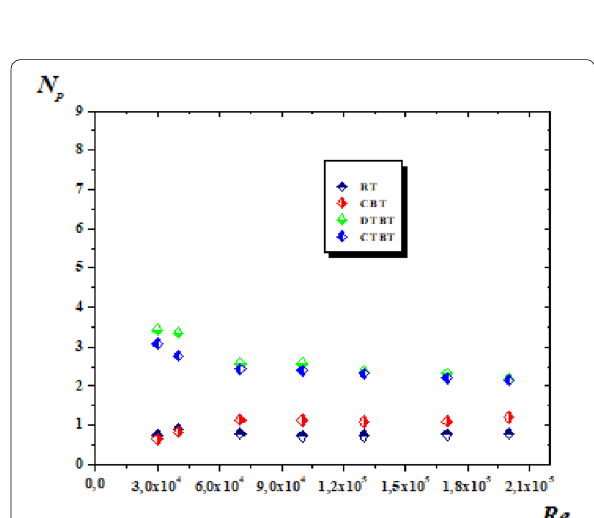
Figure 5 Power number for different agitator’s types of unbaffled